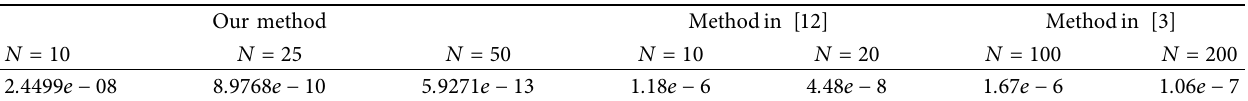
‖ ) value for Example 2 using our method and those presented in the articles [3, N ∞